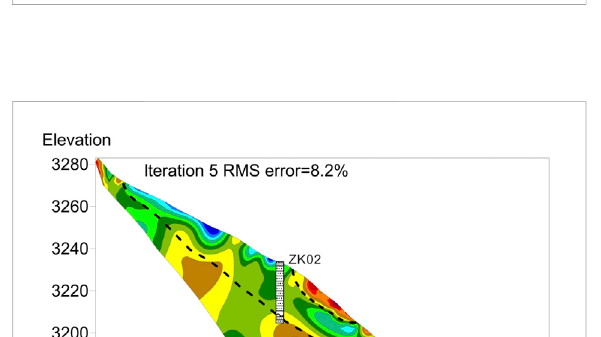
FIGURE 2 Inversion results of L1 survey line.